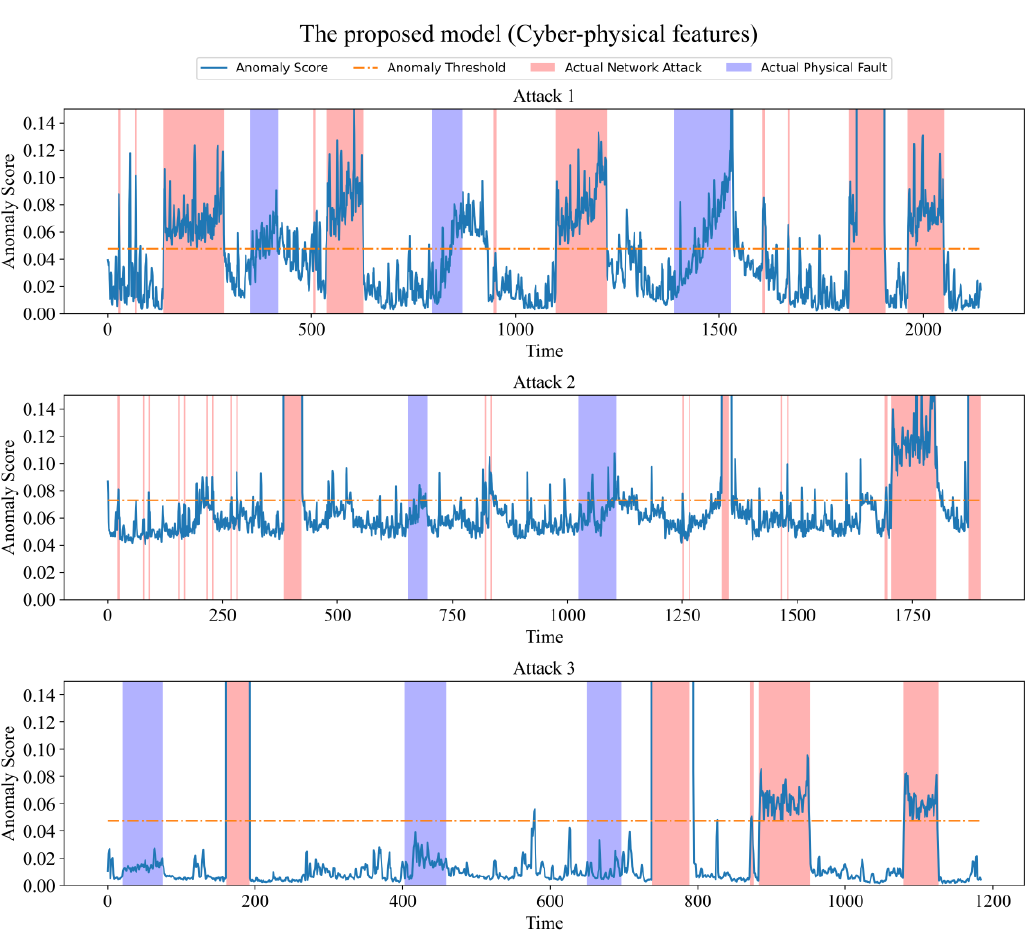
Figure 7. Anomaly scores for the proposed model (using cyber–physical features).